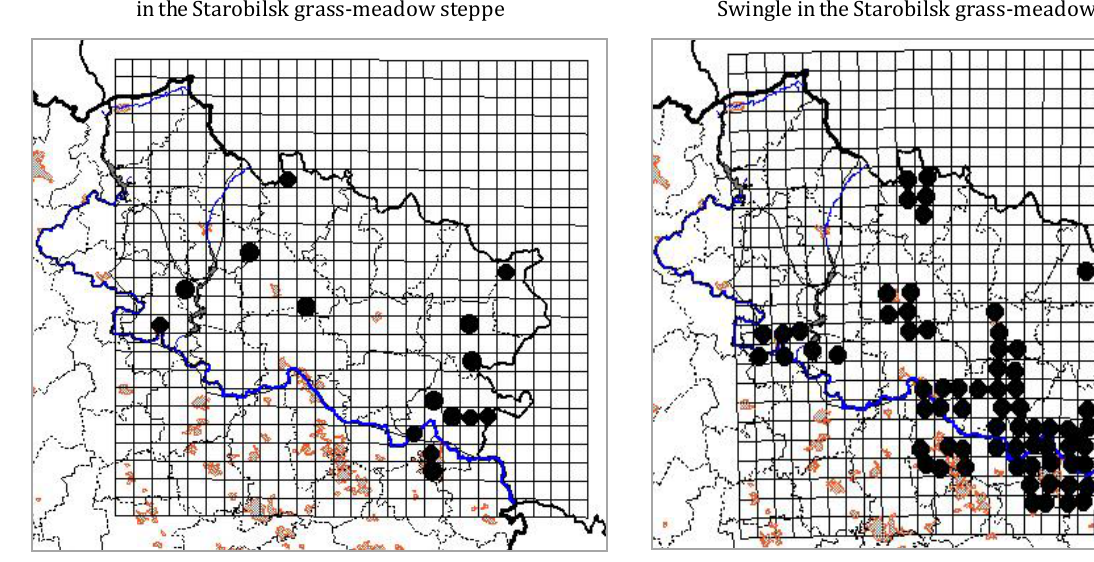
Fig. 4. The map of the distribution of Amaranthus blitoides S. Watson in the Starobilsk grass-meadow steppe